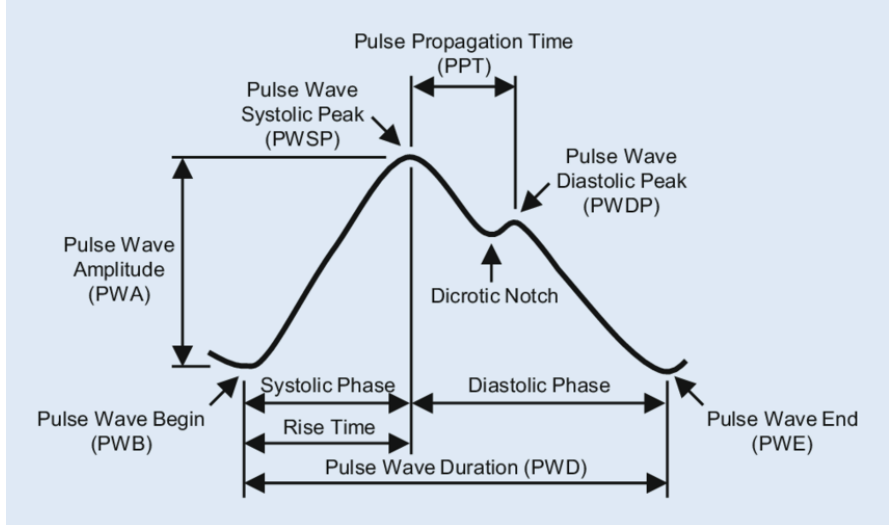
Figure 2. Typical transmission of a PPG signal with the systolic period. Reproduced with permission from [37].